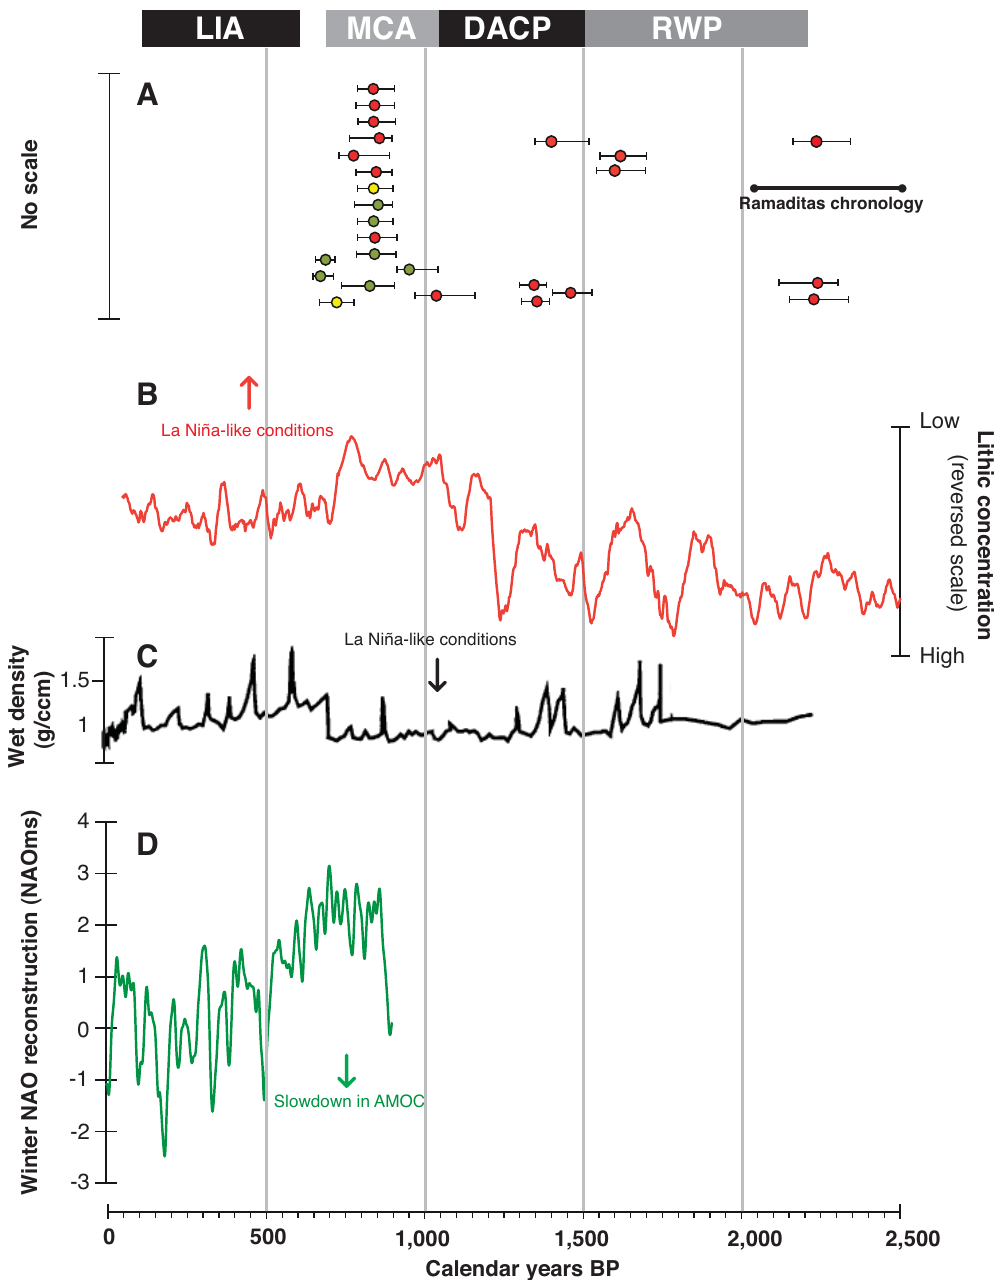
Fig. 5. Comparison of paleoclimate records: (A) all 14 C dates on paleoecological and archaeological samples from Quebrada Man´ı. Green circles: relict tree mounds and rodent burrows; red circles: organic materials associated with farming (irrigation) structures. Yellow circles: maize remains (in situ canes and corn cob found in a rodent burrow). Heavy horizontal dark line with circles indicates the chronology for Ramaditas archeological site (Rivera, 2005). (B) A 30-yr running average for lithic concentrations derived from sediment core SO147- 106KL collected offshore central Per´u; low lithic concentrations are interpreted as reduced precipitation runoffs associated to prevailing La Ni˜na-like conditions (red arrow up) over the Tropical Pacific (Rein et al., 2005). (C) Wet sediment density from Laguna Aculeo (Jenny et al. 2002); reduced sediment density implies low frequency of flood sediment deposition as sustained La Ni ˜ na-like conditions (black arrow down) promote reduced winter precipitation across central Chile. (D) Winter NAO reconstruction (further details on the estimation of NAOms, see Trouet et al., 2009); negative NAOms values are interpreted as a subdued Atlantic meridional overturning circulation (AMOC; green arrow down). Major global climate events over the last 2500yr such as Little Ice Age (LIA), Medieval Climate Anomaly (MCA), Dark Ages Cool Period (DACP) and the Roman Warm Period (RWP) are indicated at top of